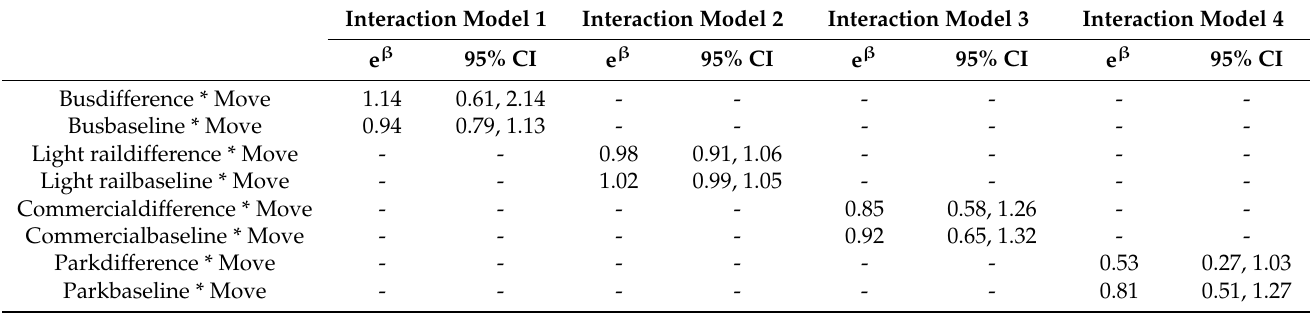
Table A2. Results from tests for interactions.